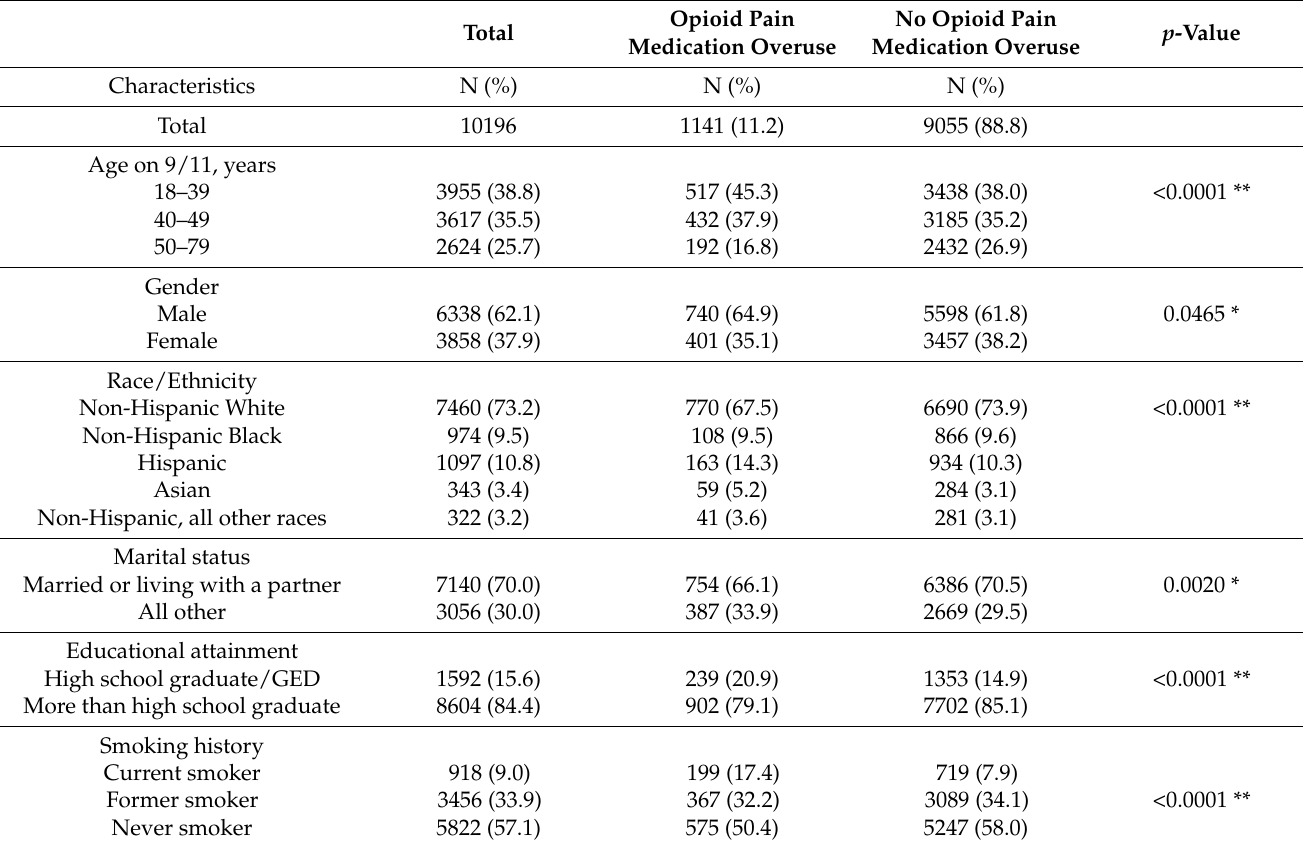
Table 2. Sociodemographic characteristics, rheumatoid arthritis (RA), and 9/11-related active PTSD symptoms by pain medication overuse among WTCHR enrollees 1 (N =